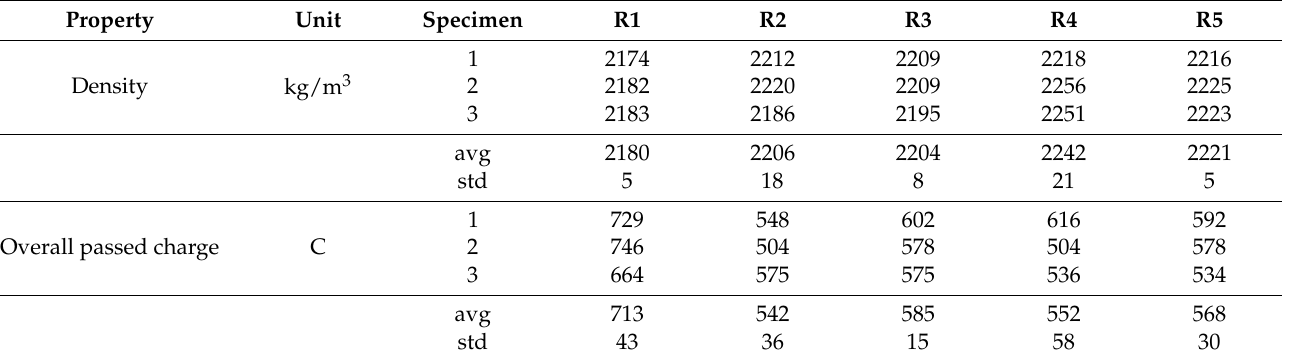
Table 9. Density D and total charge transfer